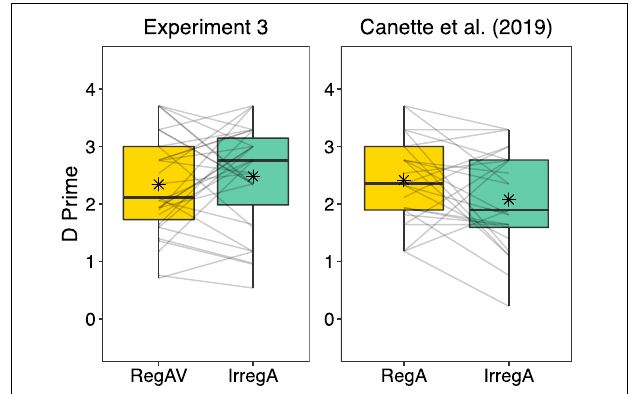
FIGURE 5 | Comparison of the current audio-visual (AV) experiment (Experiment 3; audio-visual regular primes: RegAV, auditory-only